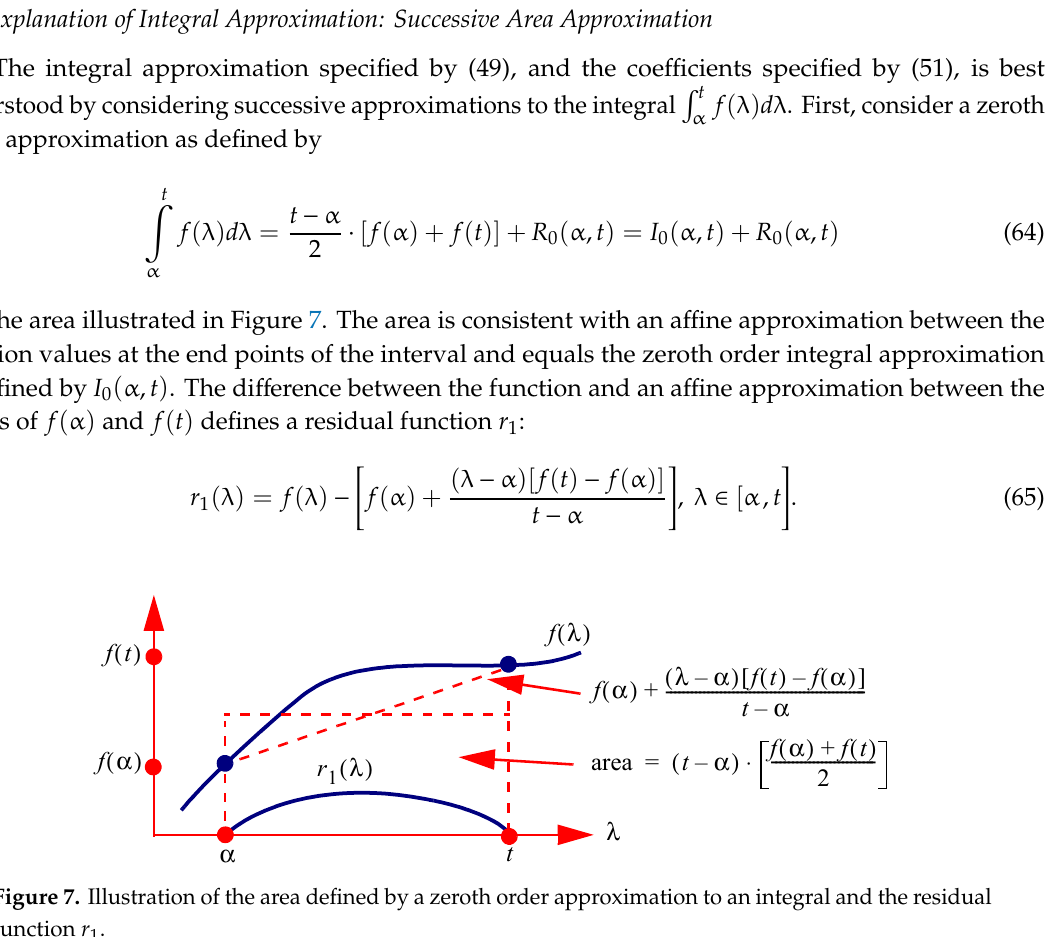
Figure 7. Illustration of the area defined by a zeroth order approximation to an integral and the residual function . r 1 Figure 8. 1 ( ) α( ) rate of change of f